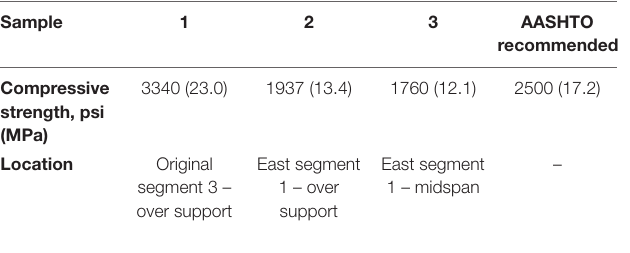
TABLE 2 | Compressive test results for concrete cores.